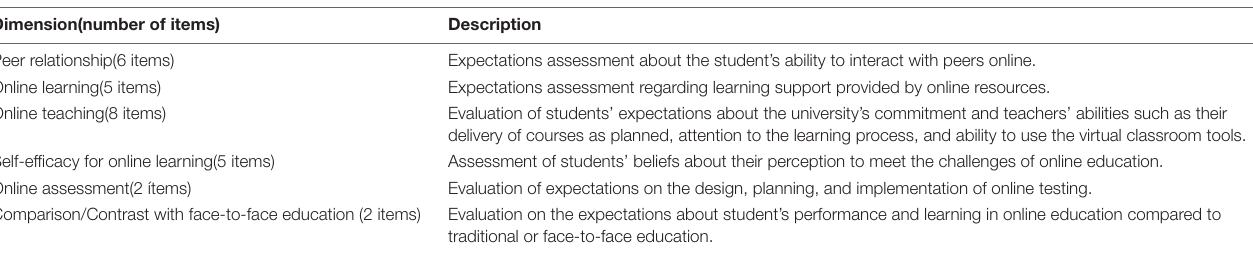
TABLE 2 | Description of the dimensions of the CEEVESE questionnaire. Dimension(number of